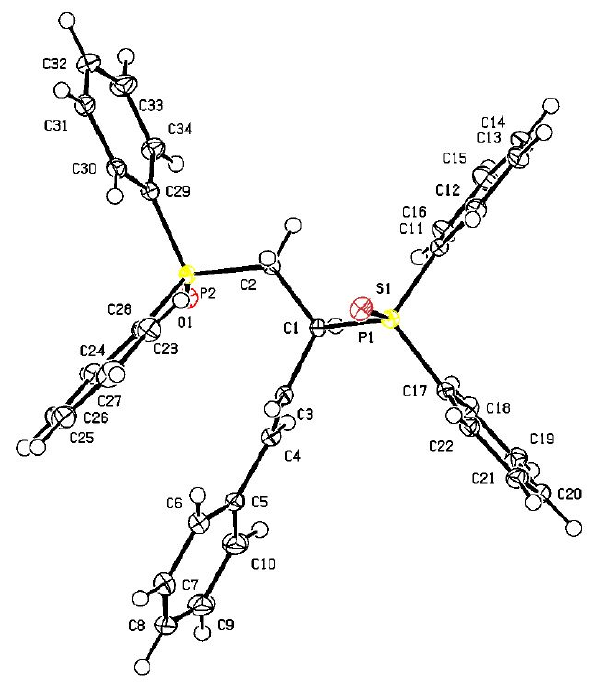
Figure 1 represented the result of X-ray single-crystal structure analysis of the double- bond isomerization product 6b . The result shown in Figure 1 clarifies the regio- and stereoselective formation of E -isomer as a single product, having different types of phos- phorus functional groups in one molecule. Such a compound with both two phosphorus functional groups and one vinyl functional group is very rare; thus, the developed method in this work will be a powerful protocol for the facile preparation of a variety of new phosphorus ligands.